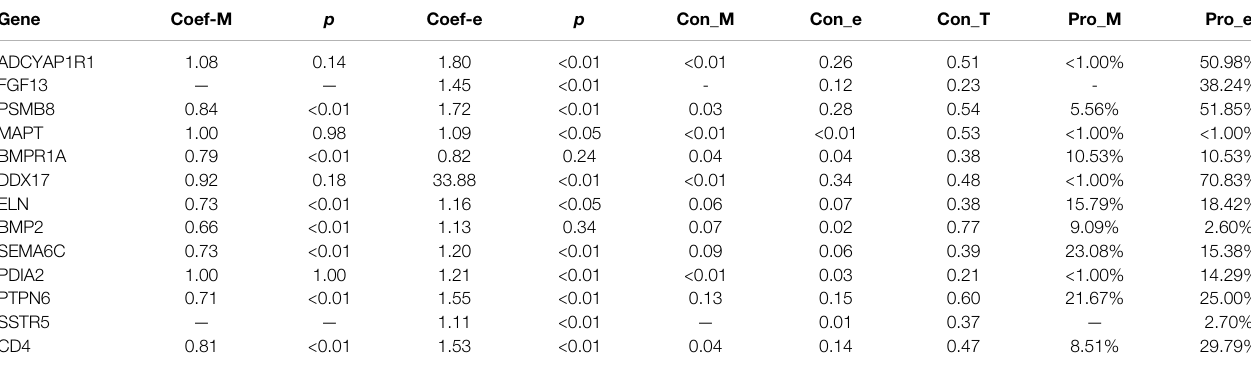
The table results were all collected from the multivariable model, including age, grade, gender, radiotherapy, IDH, mutation, 1p19q codeletion, target gene methylation level, and eRNA, level.Coef-M:coef fi cientofmethylation;Coef-e:coef fi